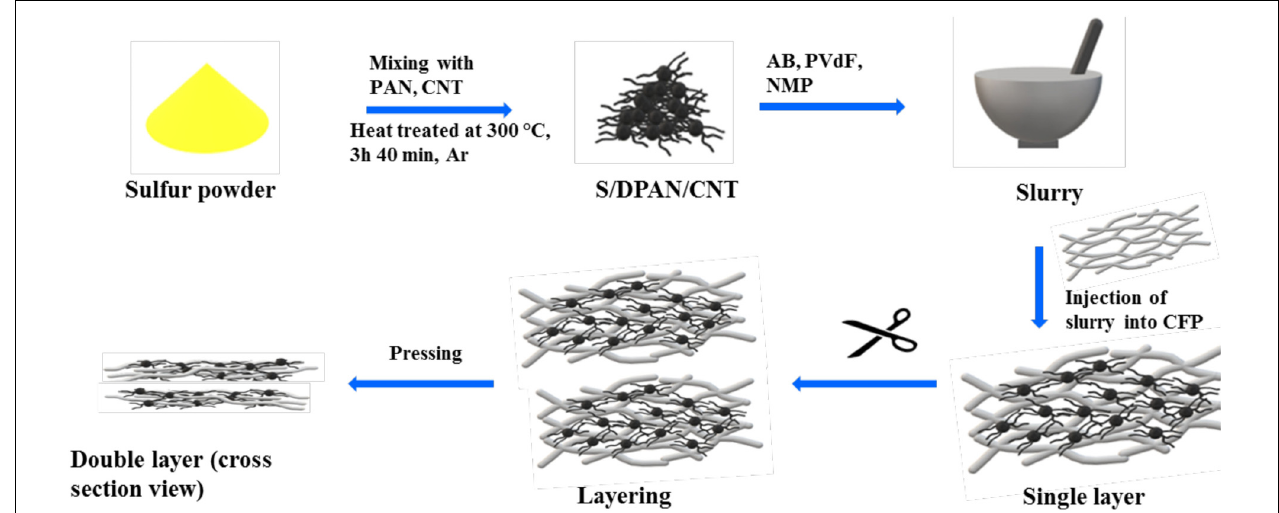
FIGURE 1 | A schematic representation illustrating the preparation and injection process of sulfur composites into 3D current